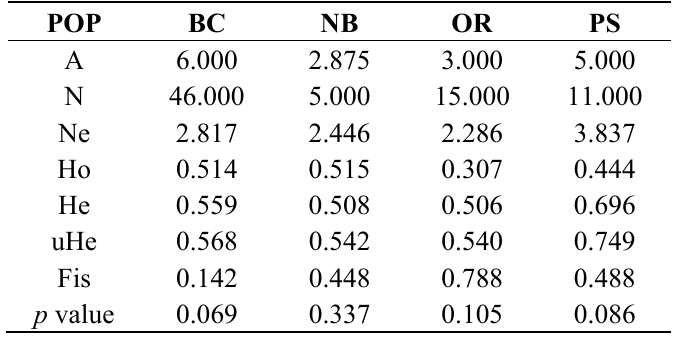
Table 1. Diversity measured within giant Pacific octopuses.